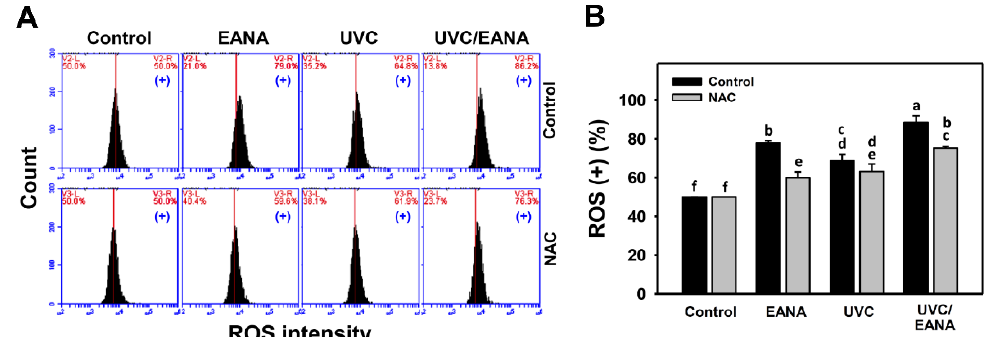
Figure 4. ROS analyses of EANA and/or UV treatments for human oral cancer Ca9-22 cells. Cells were treated with control (DMSO only), EANA (5 µg/mL), UVC (12 J/m 2 ), and combined treatment (UVC/EANA) for 12 h. ( A ) Typical flow cytometry patterns for ROS content. ROS intensity-positive regions were marked as (+). ( B ) Statistical analysis for (A). Treatments showing no overlapping labels (a–f) differ significantly between multiple comparisons ( p < 0.05–0.0001). Data, mean ± SD ( n = 3).